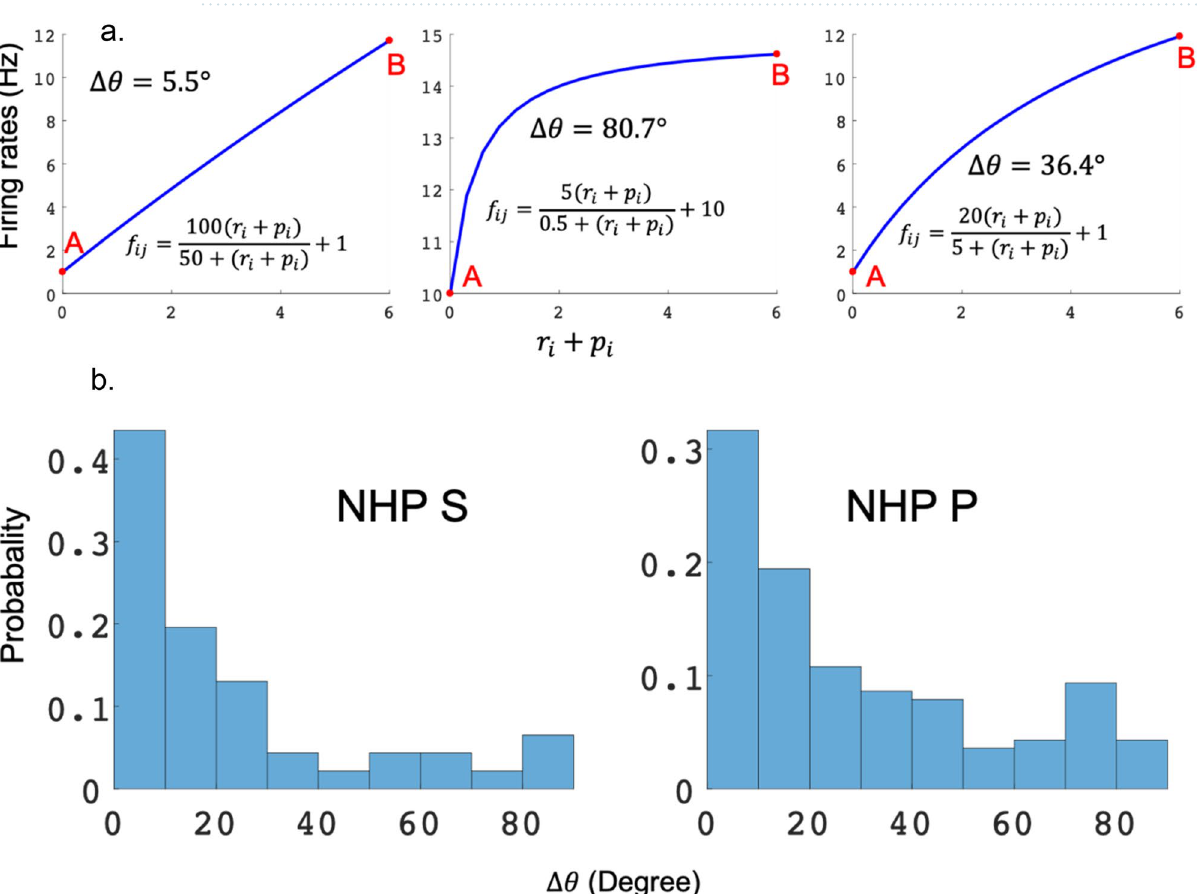
Figure 5. ( a ) Description of method used to determine % of the population with sigmodal or linear response curves from the population that were not hyperbolic. ( b ) Distribution of �θ for the non-hyperbolic units using model 2. Note that most non-hyperbolic units had a �θ < 30° making their responses approximately linear. All units shown here were not hyperbolic, that is, the red portion of the bars seen in Fig. 4